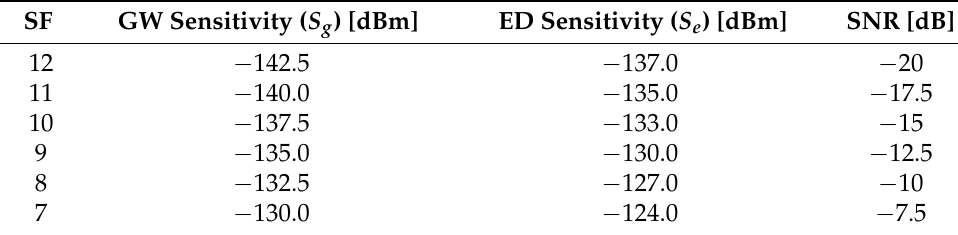
Table 3. Sensitivity and Required SNR of EDs and GW with 125-kHz mode [16,20,21].